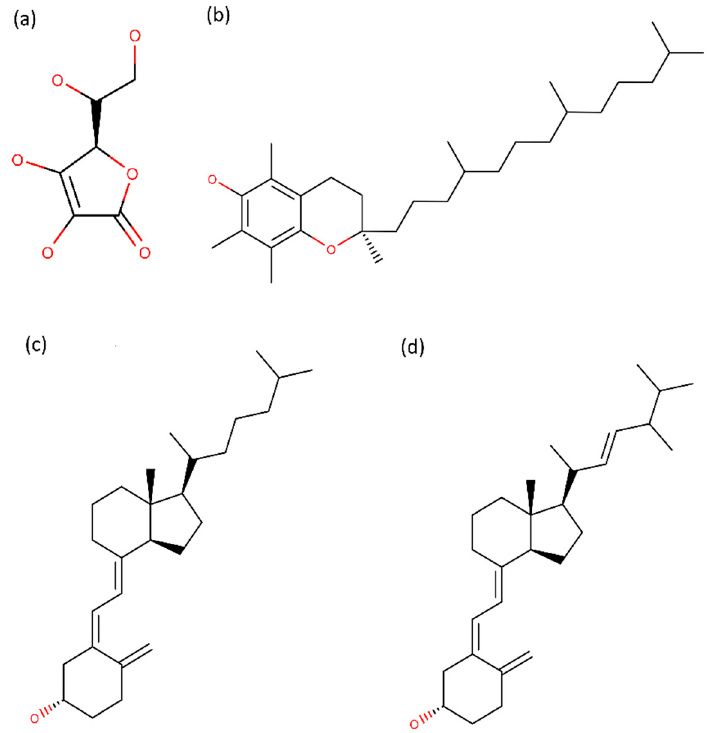
Figure 2. Chemical structures of: ( a ) vitamin C, ( b ) vitamin E, ( c ) vitamin D 3 and ( d ) vitamin D 2 .